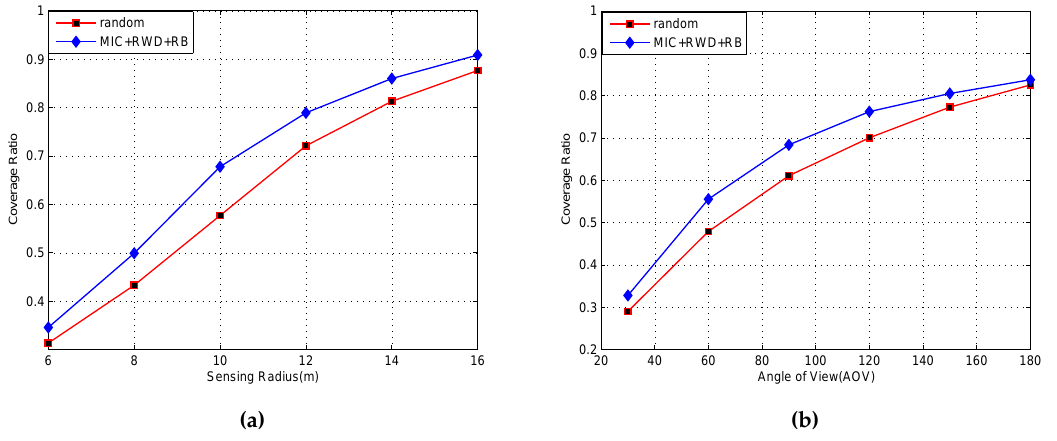
Figure 8. The influence of R s and AoV on coverage ratio. ( a ) MIC + RWD + RB compared with random(n = 120, AoV = 90 ◦ , R s = 6 m, 8 m,..., 16 m); ( b ) MIC + RWD + RB compared with random (n = 120, R s =10 m, AoV = 30 ◦ , 60 ◦ ,..., 180 ◦